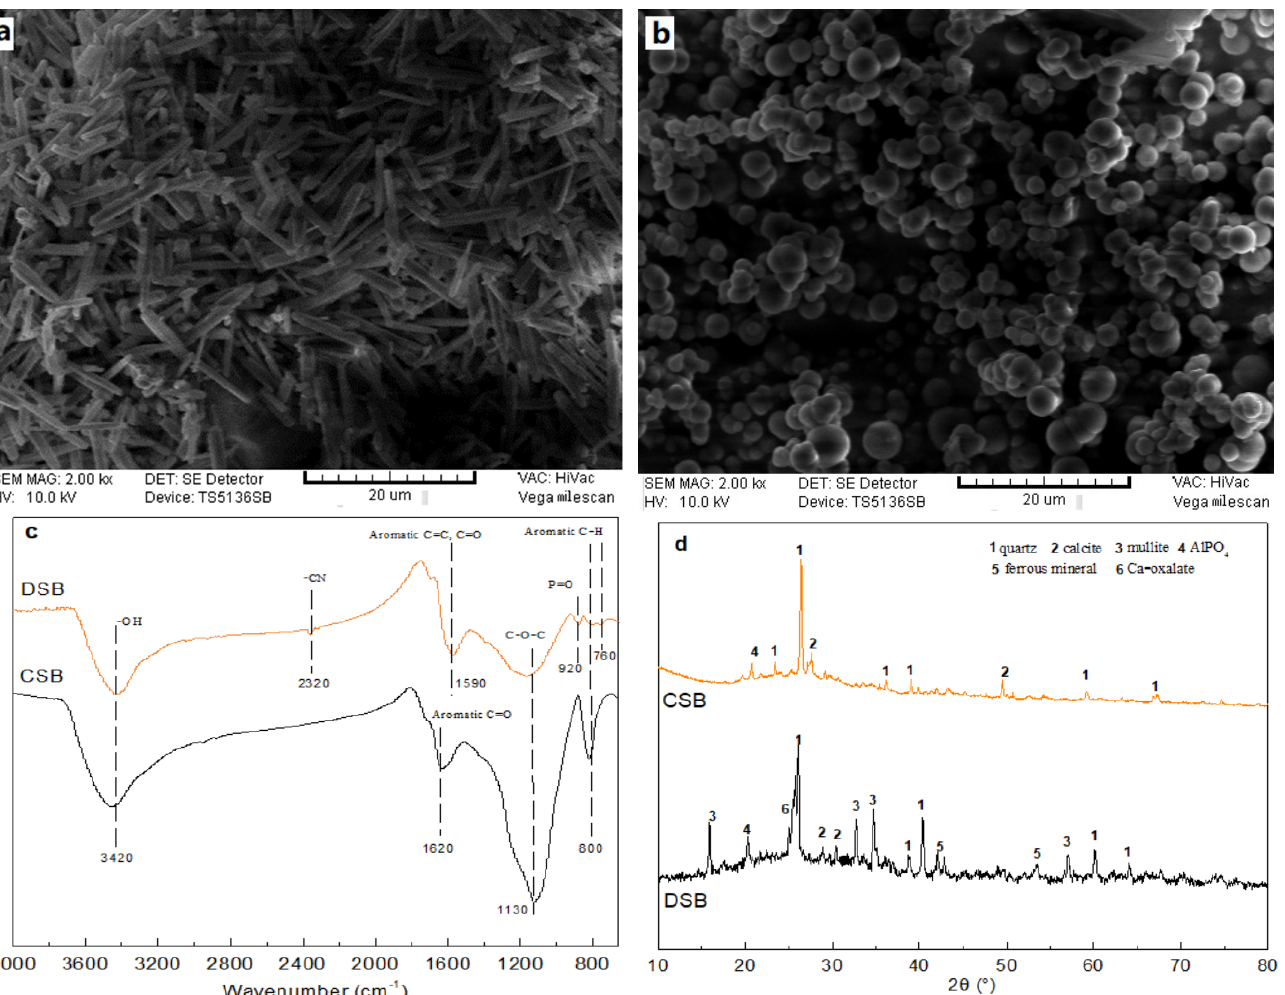
Figure 1. SEM images of CSB ( a ) and DSB ( b ), and the FT-IR spectrums ( c ) and XRD patterns ( d )